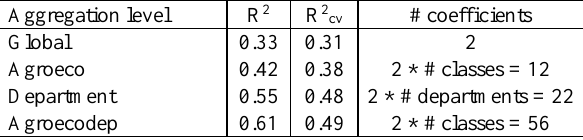
Table 1. R 2 and cross-validated R 2 for different aggregation levels and number of coefficients to be tuned